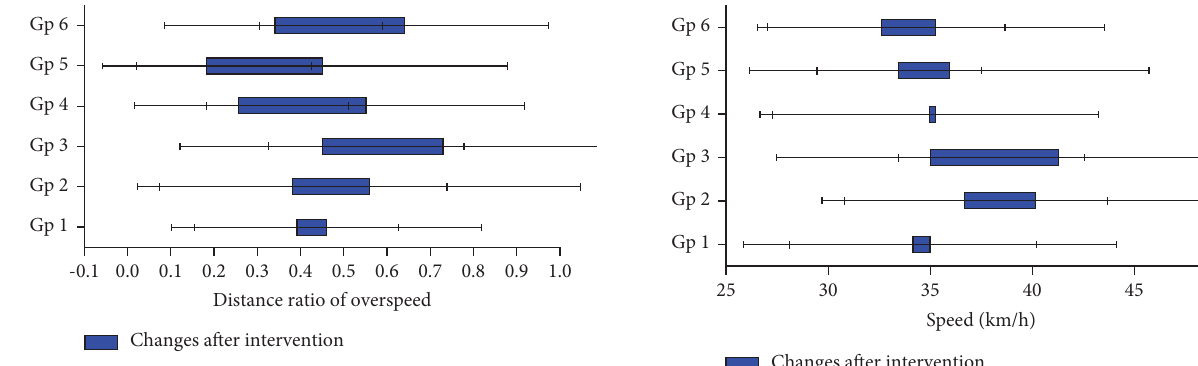
Figure 4: Changes in the distance ratio of overspeed in the 40km/h zone after the intervention (the error bars represent the standard variance).